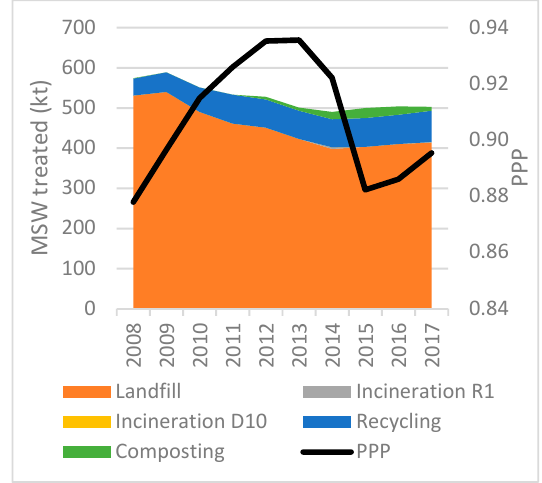
Figure 26. Waste treatment method and PPP in Cyprus 2008–2017 (European Statistics 2019b, 2019c).